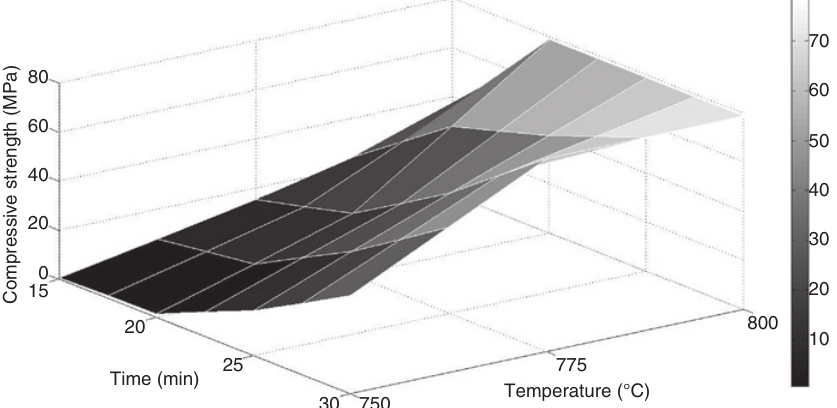
Figure 11: MG30 compressive strength as a function of sintering temperature and